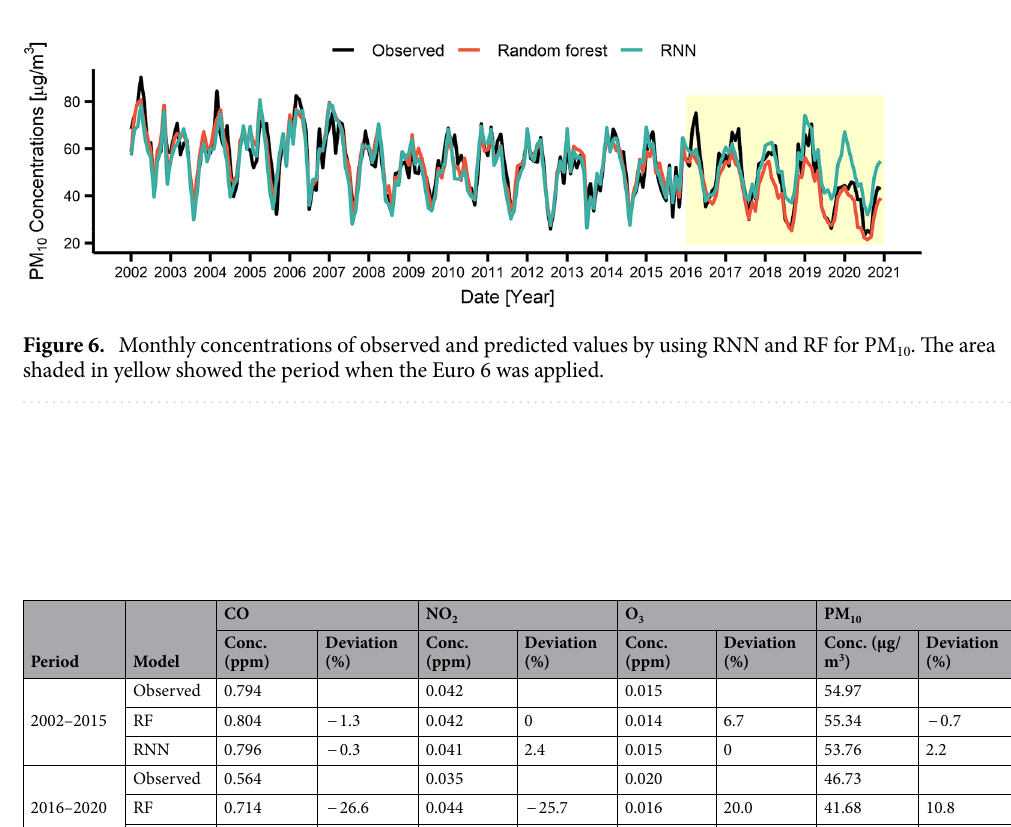
Figure 5. Monthly concentrations of observed and predicted values by using RNN and RF for O 3 . The area shaded in yellow showed the period when the Euro 6 was applied.